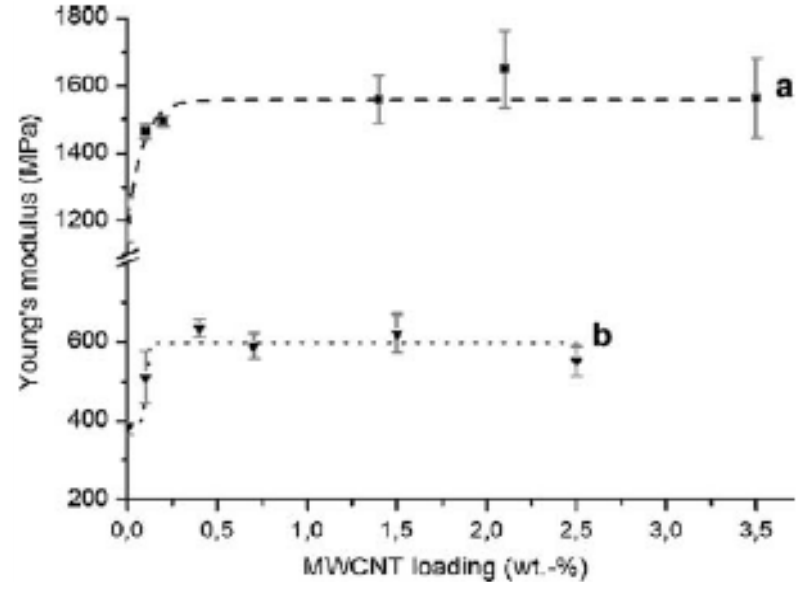
Figure 49. Young’s modulus of iPP/MWCNTs nanocomposites (a) and sPP/MWCNTs nanocomposites (b) as a function of MWCNTs loading. Reproduced with permission from ref.